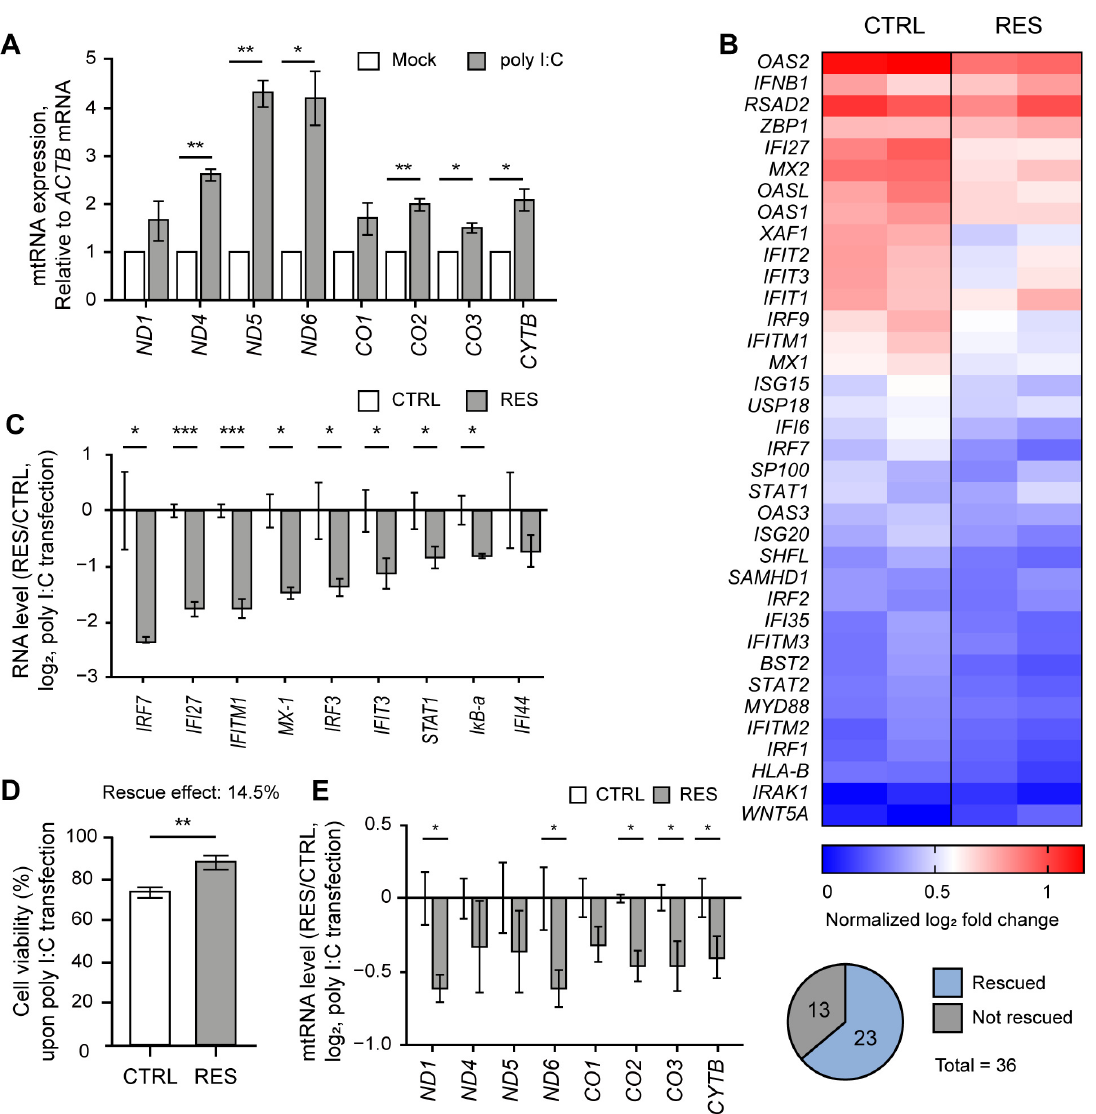
Figure 1. RES alleviated the IFN response by poly I:C. ( A ) The expression of mtRNAs in NS-SV-AC cells upon poly I:C transfection. ( B ) Heatmap of mRNA-seq results upon poly I:C transfection with or without RES pretreatment for type I IFN genes. The two columns represent log 2 fold changes of two biological replicates. ( C ) The ratios of ISG induction upon poly I:C transfection between RES-pretreated and control samples. ( D ) The APH assay was used to measure the effect of RES pretreatment on cell viability. n = 4 and error bars are s.e.m. ( E ) The ratios of mtRNAs induction upon poly I:C transfection between RES-pretreated and control samples. For ratios, Cq values were first normalized to that of ACTB mRNA. For untreated samples, the values were normalized to RNAs from control cells without poly I:C transfection. Similarly, RNAs from RES-pretreated cells with poly I:C transfection were normalized separately from those from RES-treated cells without poly I:C. Unless mentioned otherwise, three independent experiments were carried out, and error bars denote s.e.m. All statistical significances were calculated using one-tailed Student’s t-tests; * p ≤ 0.05, ** p ≤ 0.01, and *** p ≤ 0.001.